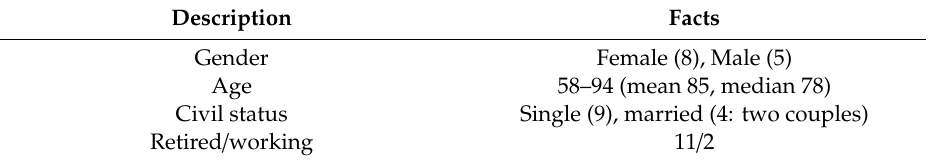
Table 3. Gender, age, civil status, and working status of the occupants in the present